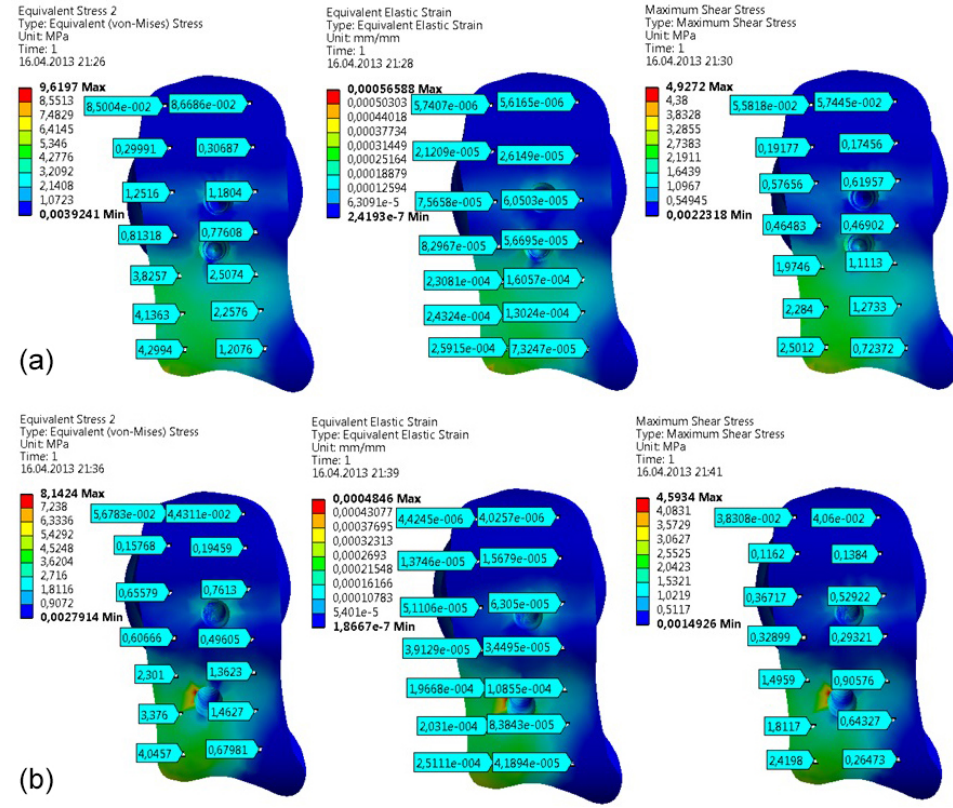
Figure 3. The biomechanical parameters on the proximal surface of the fracture line for both